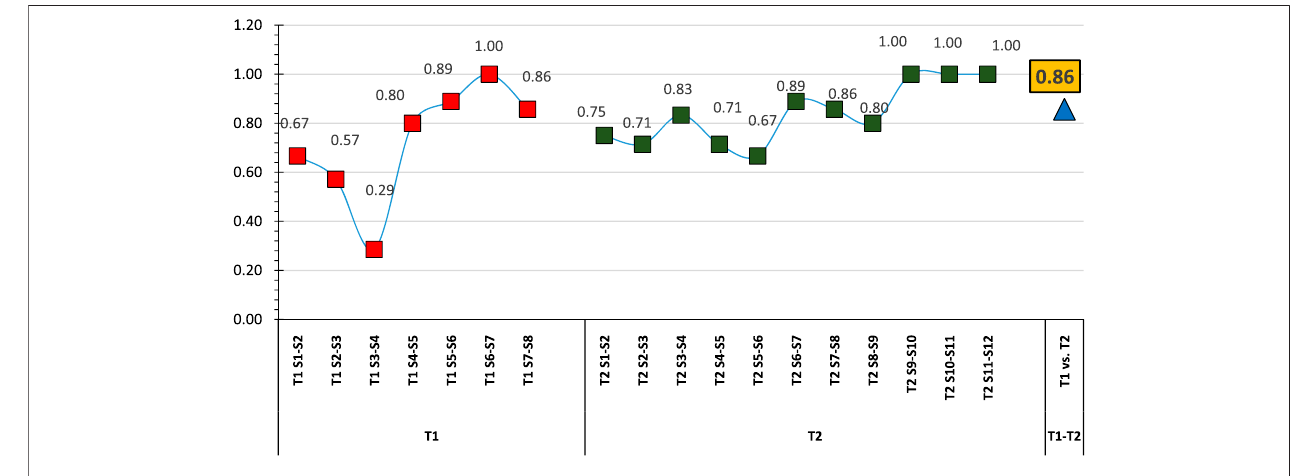
FIGURE 5 | Beta diversity (Sorensen ’ s coef fi cient) determined for the two river sections T1 and T2.